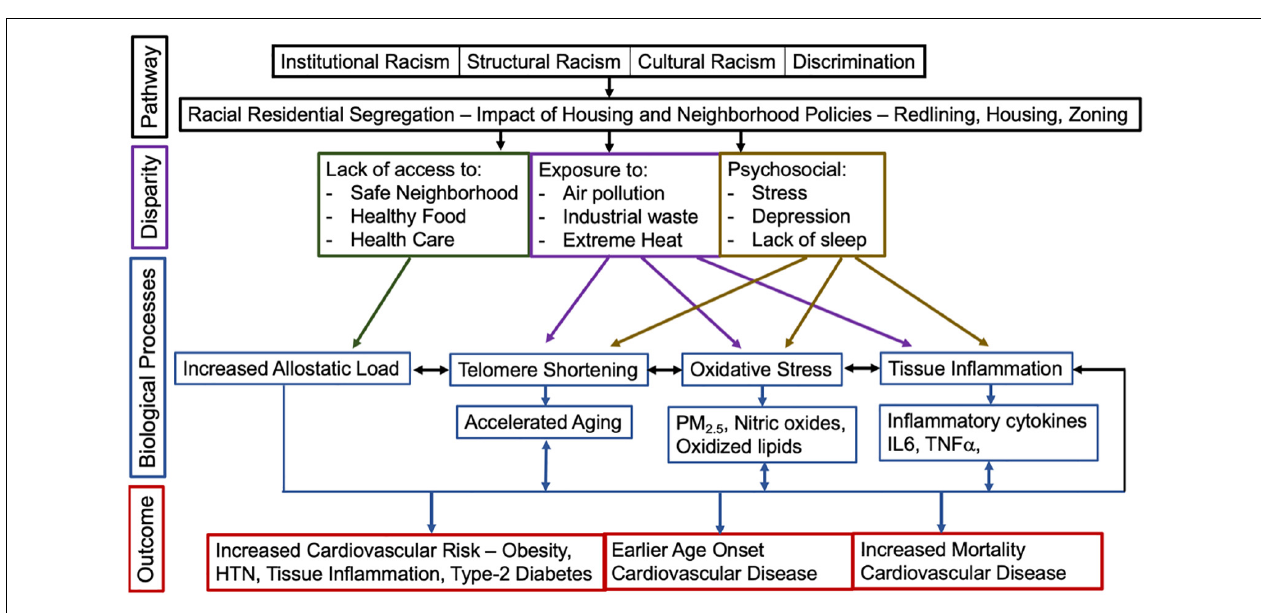
FIGURE 2 | The impact of racist and discriminatory housing policies, disparities, biological processes on the risk for, the age of onset, and mortality experienced by Black/African American individuals from cardiovascular